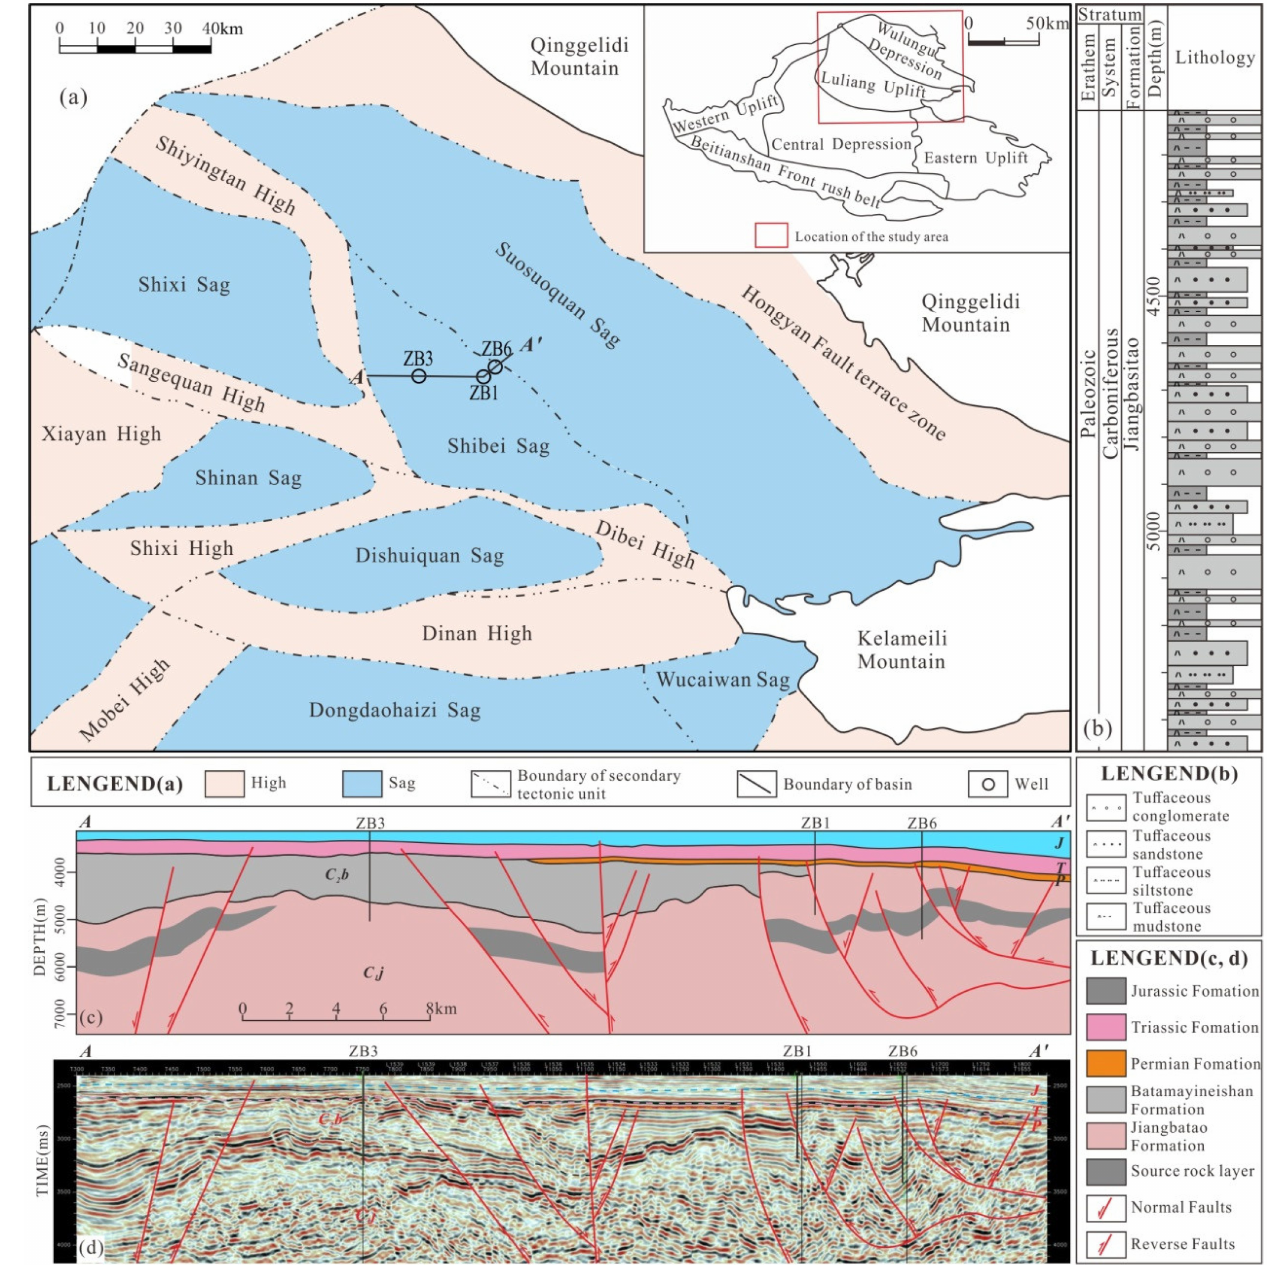
Figure 1. Tectonic location and geological section of the Shibei sag. ( a ) Tectonic location of the Shibei sag; ( b ) lithologic histogram of the Carboniferous formation of Well ZB6; ( c ) near-east–west geological profile of the Shibei sag; ( d ) near-east-west seismic profile of the Shibei sag. Early exploration of the Shibei sag was mainly aimed at the igneous reservoir near the fault zone. Well ZB1 and Well ZB3, respectively, encountered diabase and tuff in the Jiangbatao formation with better oil and gas display. However, the recently drilled Well ZB6 encountered thick conglomerate and sandstone instead of igneous rock (Figure 1b), which indicates that the reservoir types have a certain diversity. Well ZB6 is located between two large faults, and the bedding is characterized by a high angle due to the influence of fault activity (Figure